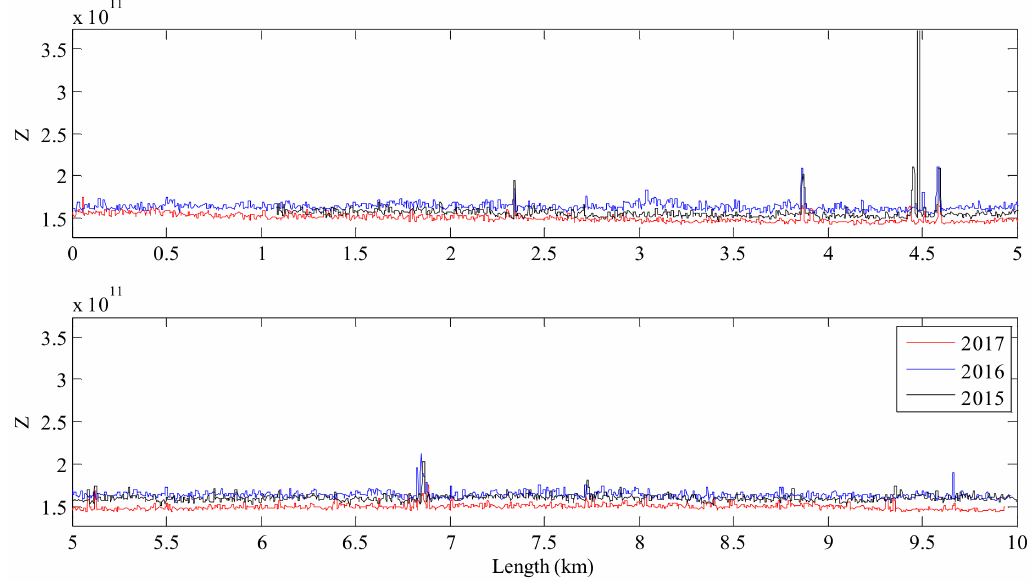
Figure 9. GPR parameter Z , in the frequency domain, regarding data from the summers of 2015, 2016 and